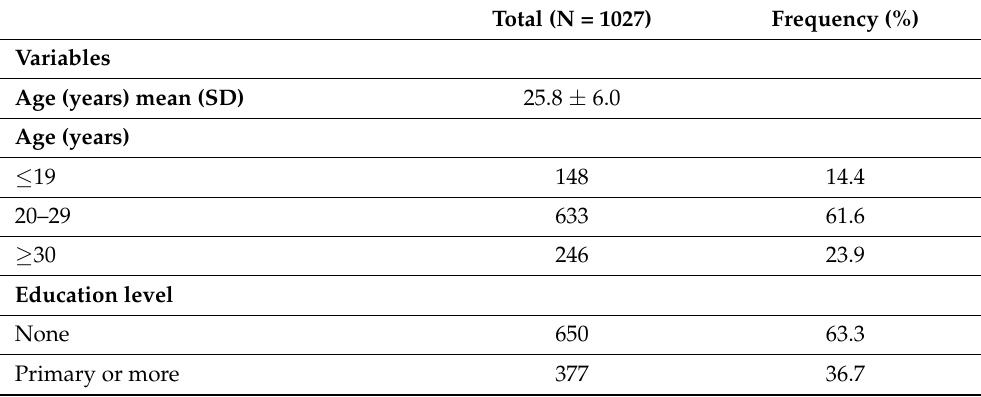
Table 1. Characteristics of the